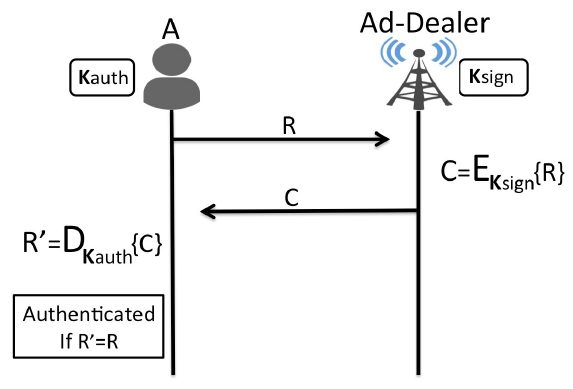
Figure 5. AD-Dealer authentication